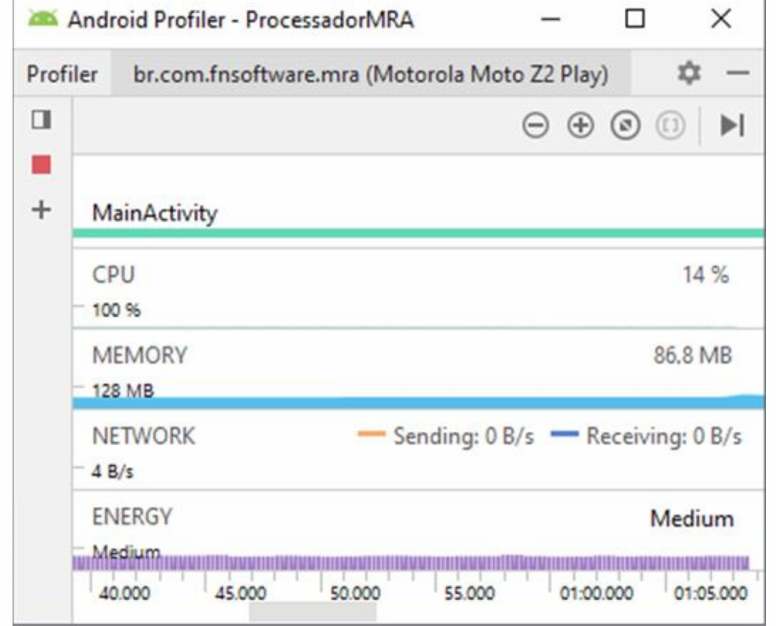
Figure 31. Overall app performance—wavelet MRA-based strategy.